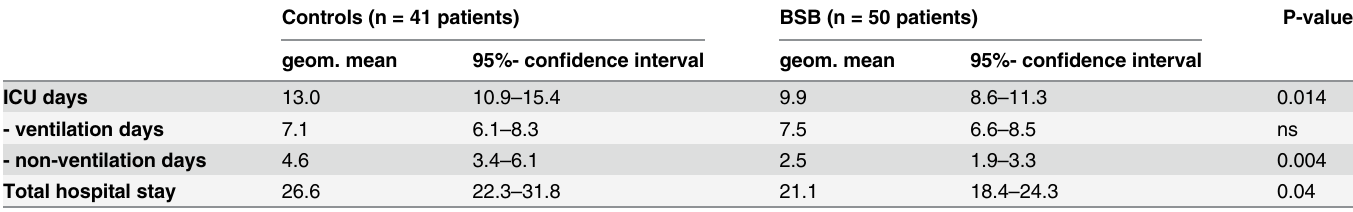
Table 5. Mean ICU length of stay per patient in days, also separated in ventilation and non-ventilation